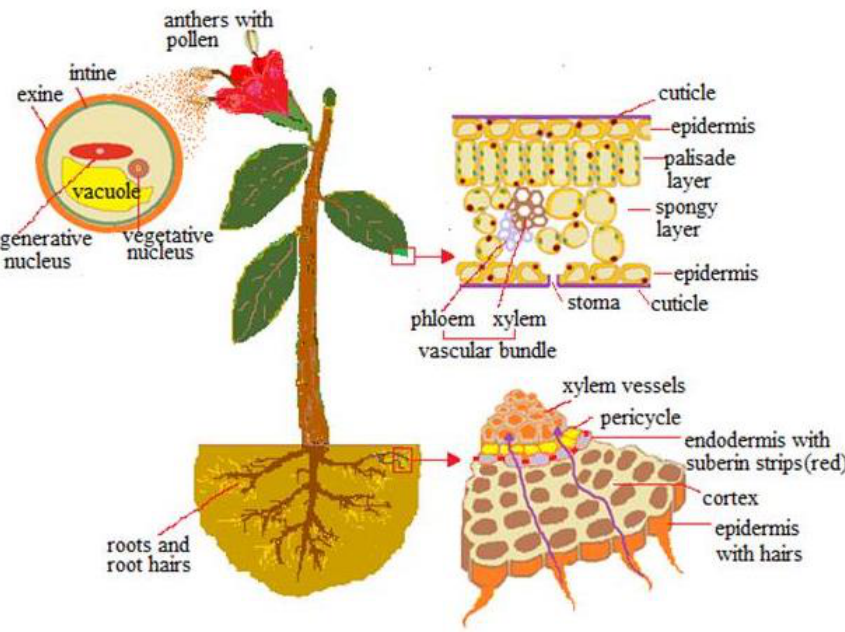
Figure 1. Pathways by which nanomaterials (NMs) are absorbed: pollen exine, cuticle, stomata, and root